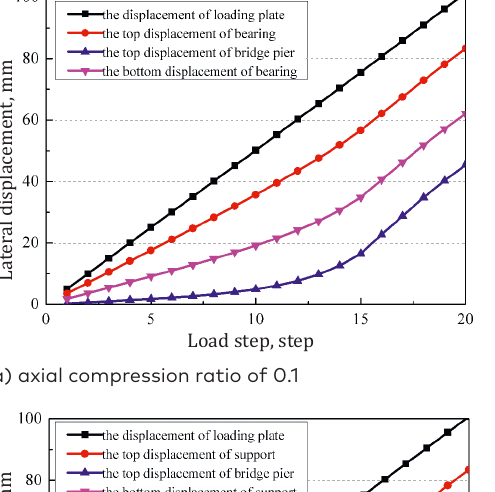
a) axial compression ratio of 0.1 b) axial compression ratio of 0.15